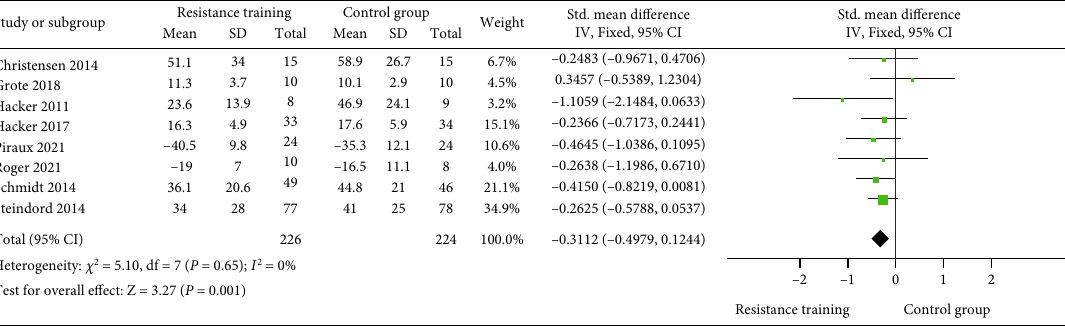
Figure 2: Forest plot of 10- to 35-session muscle strength exercise training versus no intervention for fatigue levels.